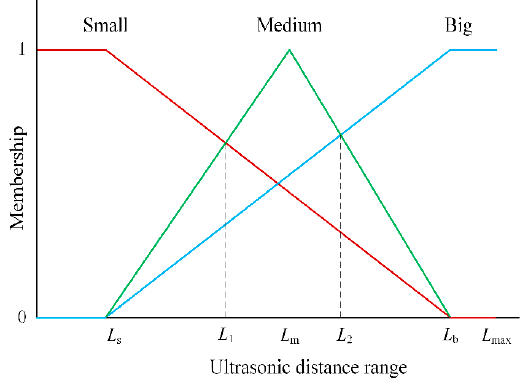
Figure 7. Membership of ultrasound distance range.